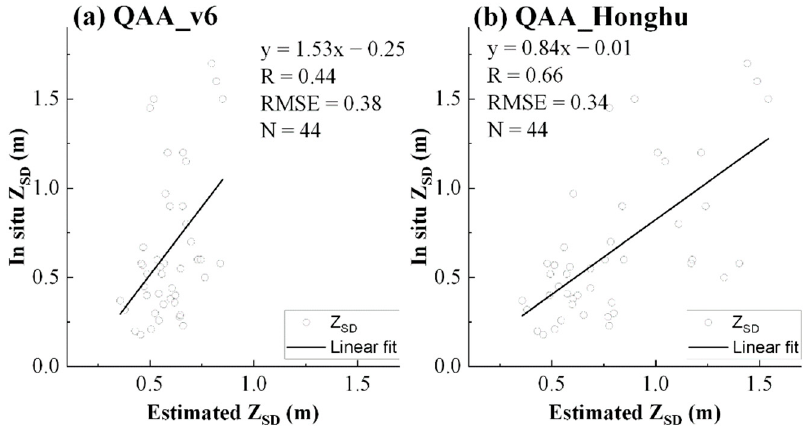
Figure 11. Comparison between in situ Z SD and estimated Z SD using ( a ) QAA_v6, ( b ) QAA_Honghu.